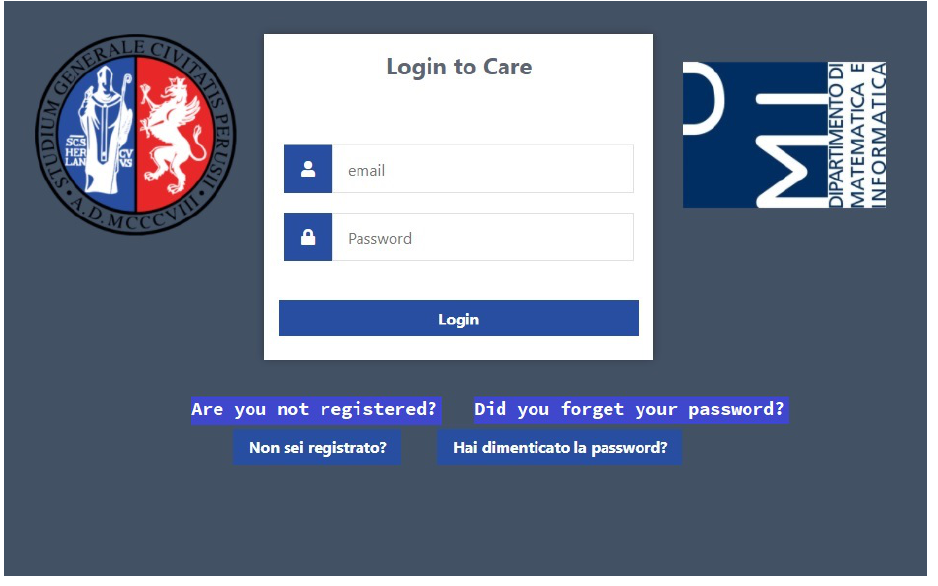
Figure 8. The homepage of the Care portal.